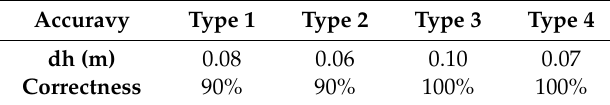
Table 3. The decomposition accuracy of waist planes.